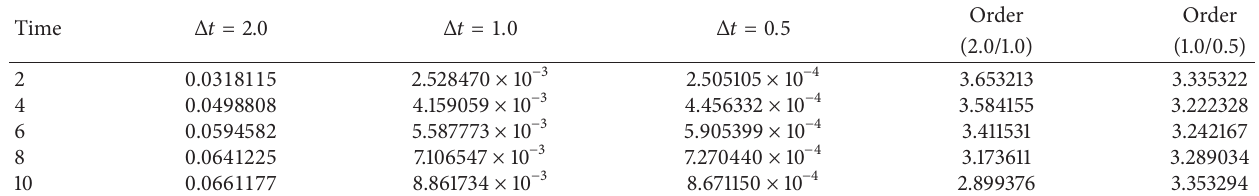
Table 9: The order of convergence in time for 𝐿 ∞ error norm with ℎ = 0.1 and 𝑐 = 0.3 .